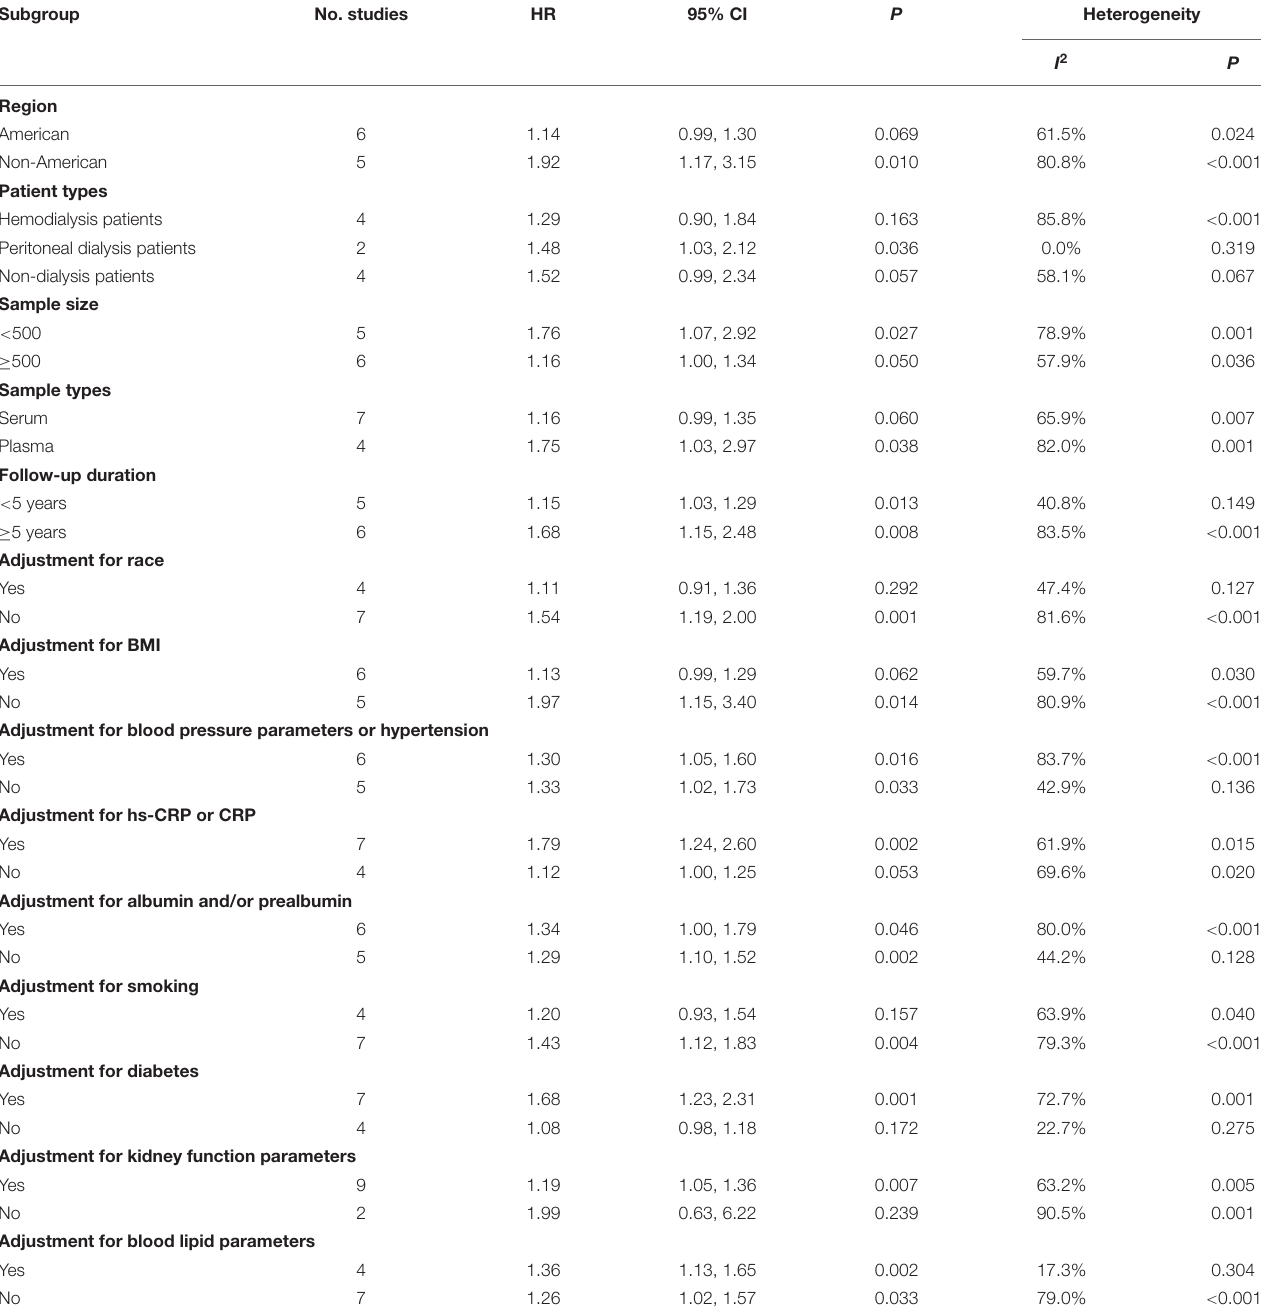
TABLE 2 | Subgroup analysis for all-cause mortality of the included studies. Subgroup No. studies HR 95% CI